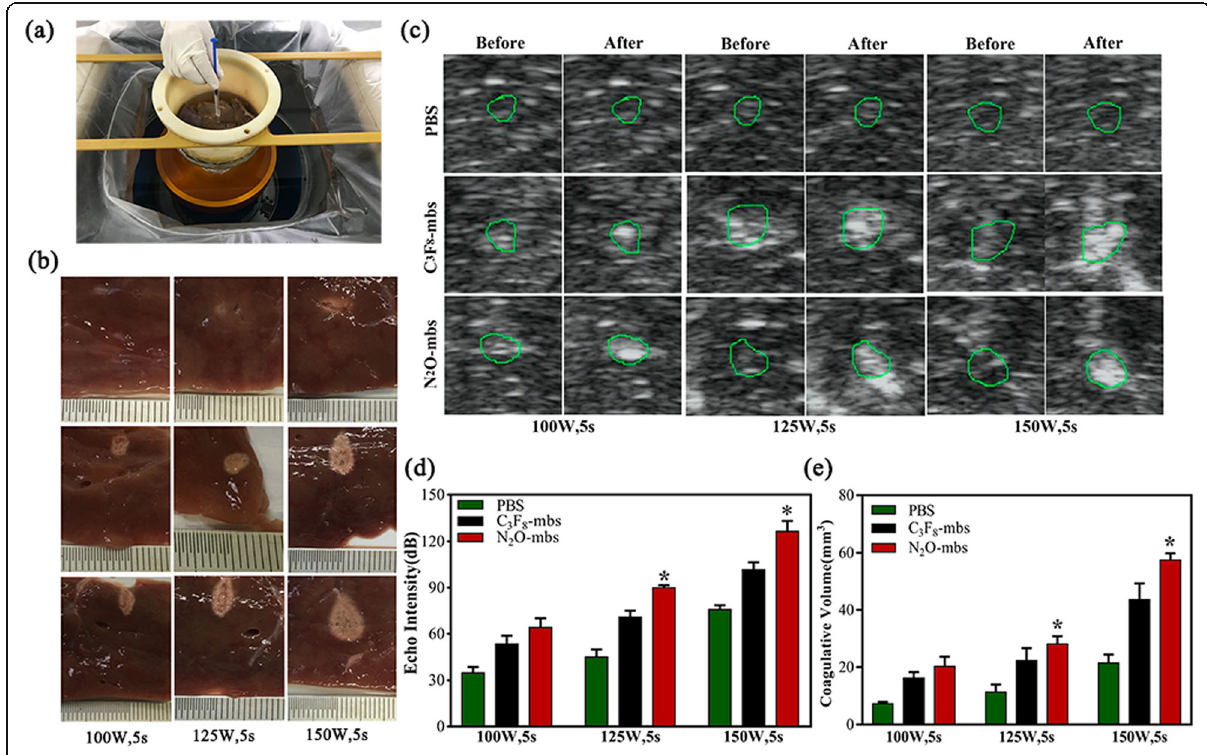
Fig. 6 a Schematic illustration of ex vivo HIFU ablation on degassed bovine livers; b photography of the targeted area in excised bovine liver after HIFU ablation; c real-time ultrasound images before and after HIFU irradiation on bovine livers at 100 W, 125 W and 150 W for 5 s; d quantitative analysis of echo intensity; e quantitative analysis of coagulative necrosis volume of the targeted area in the excised bovine liver after HIFU ablation. (The data were shown as mean ± SD, n = 5 per group, * p < 0.05, compared with 100 W, 5 s, 125 W, 5 s